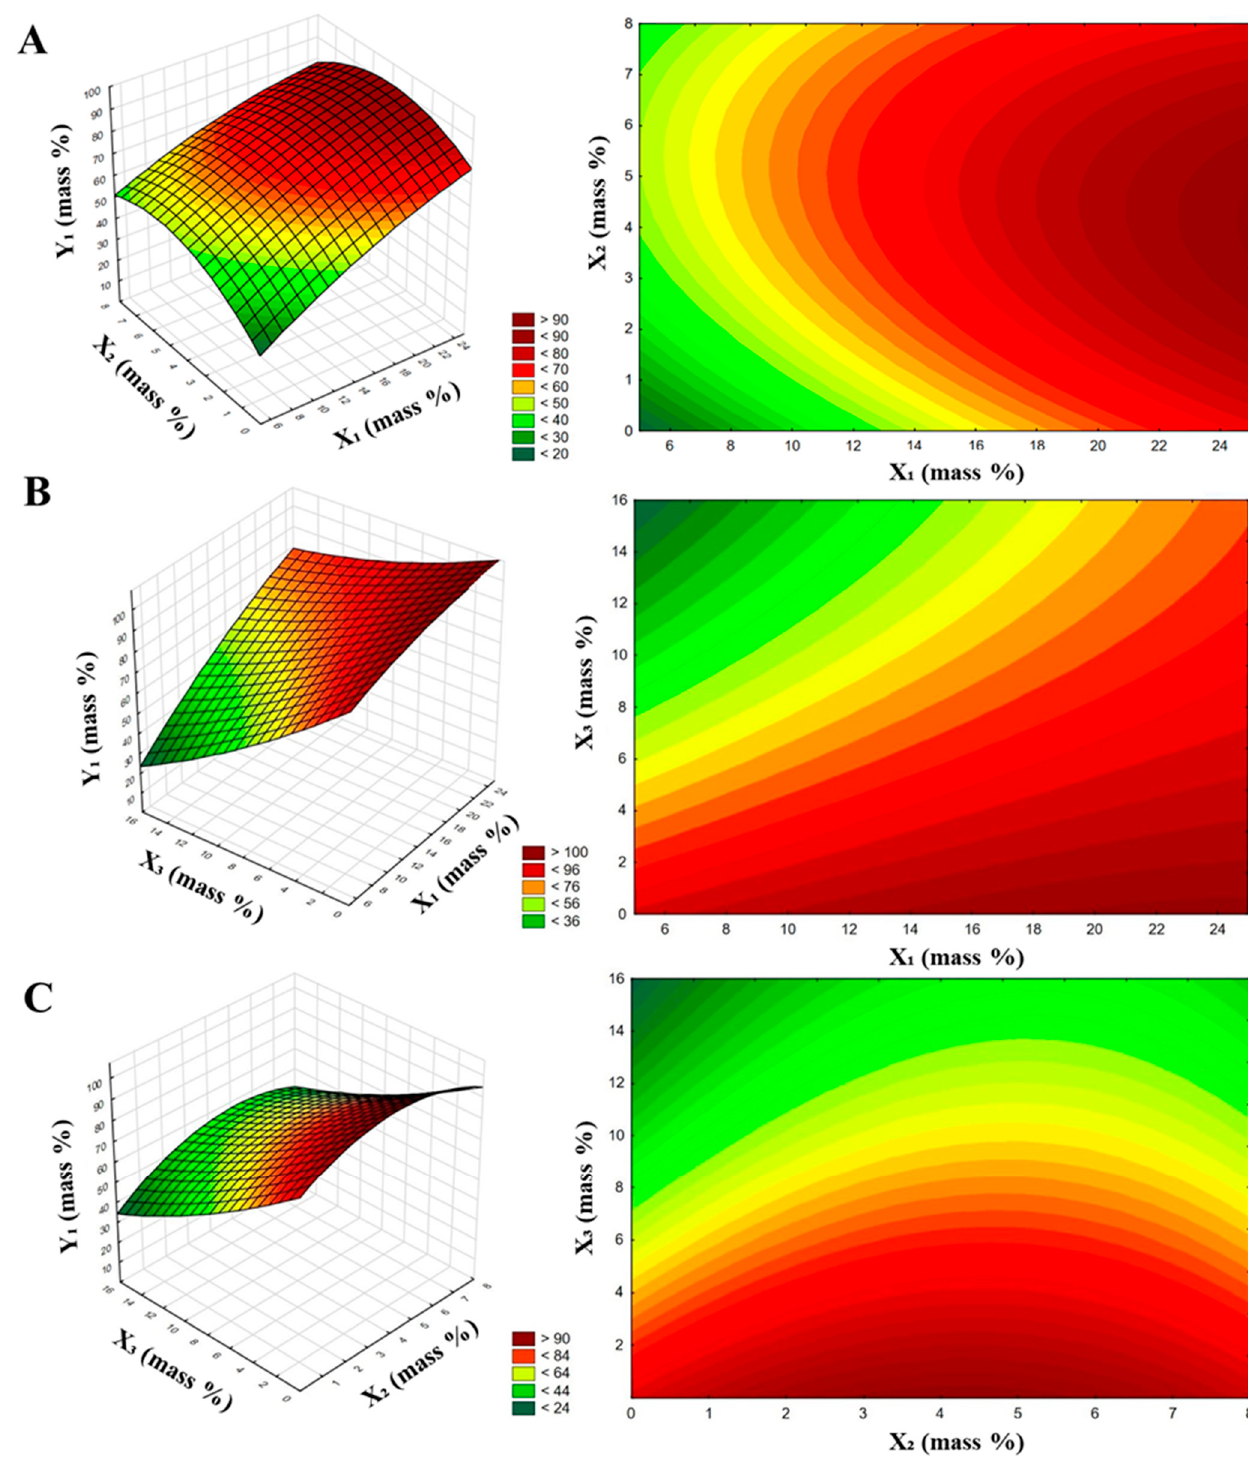
Figure 2. Response surface charts with contour charts representing the influence of the composition of coating agents on the effectiveness of caking prevention in fertilizers after granulation: ( A ) effect of fatty amine and stearic acid contents; ( B ) effect of fatty amine and surfactant contents; and ( C ) effect of stearic acid and surfactant contents.